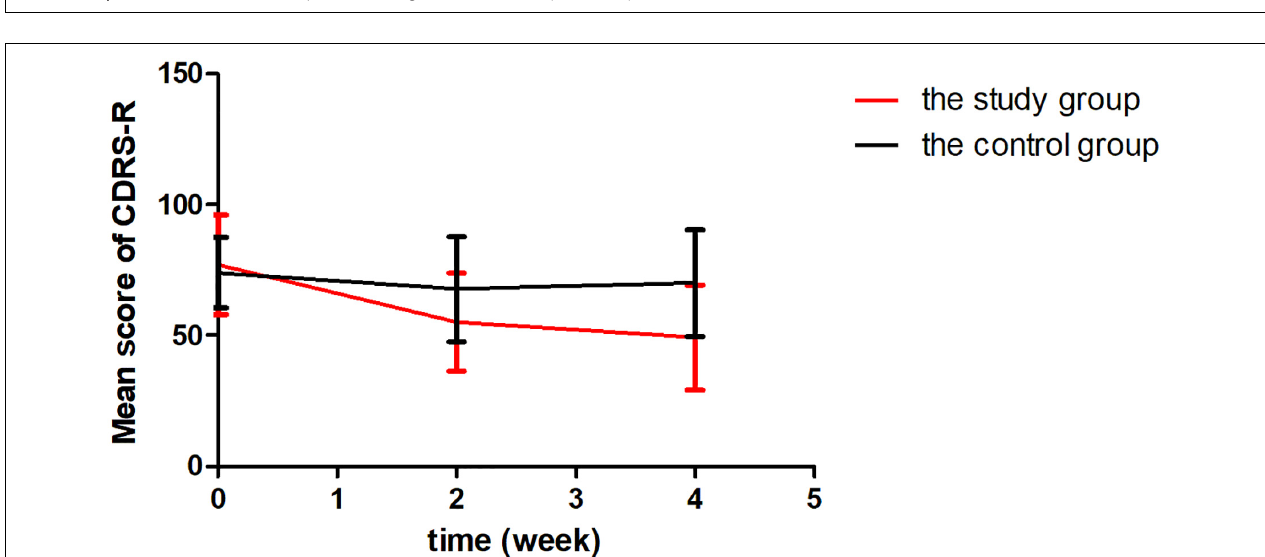
FIGURE 2 | Reduction in Children’s Depression Rating Scale-Revised